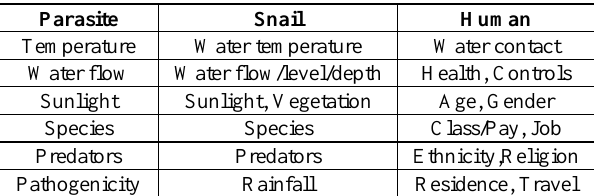
Table 1: Parasite, snail, and human factors affecting schistosomiasis transmission (adapted from Walz et al., 2015a). In order to determine predictive properties of RS-based environmental parameters, we examined monthly records of reported schistosomaisis during 2008-2015 and their associations, with time-series built from remote sensing feeds at the district level in Ghana.